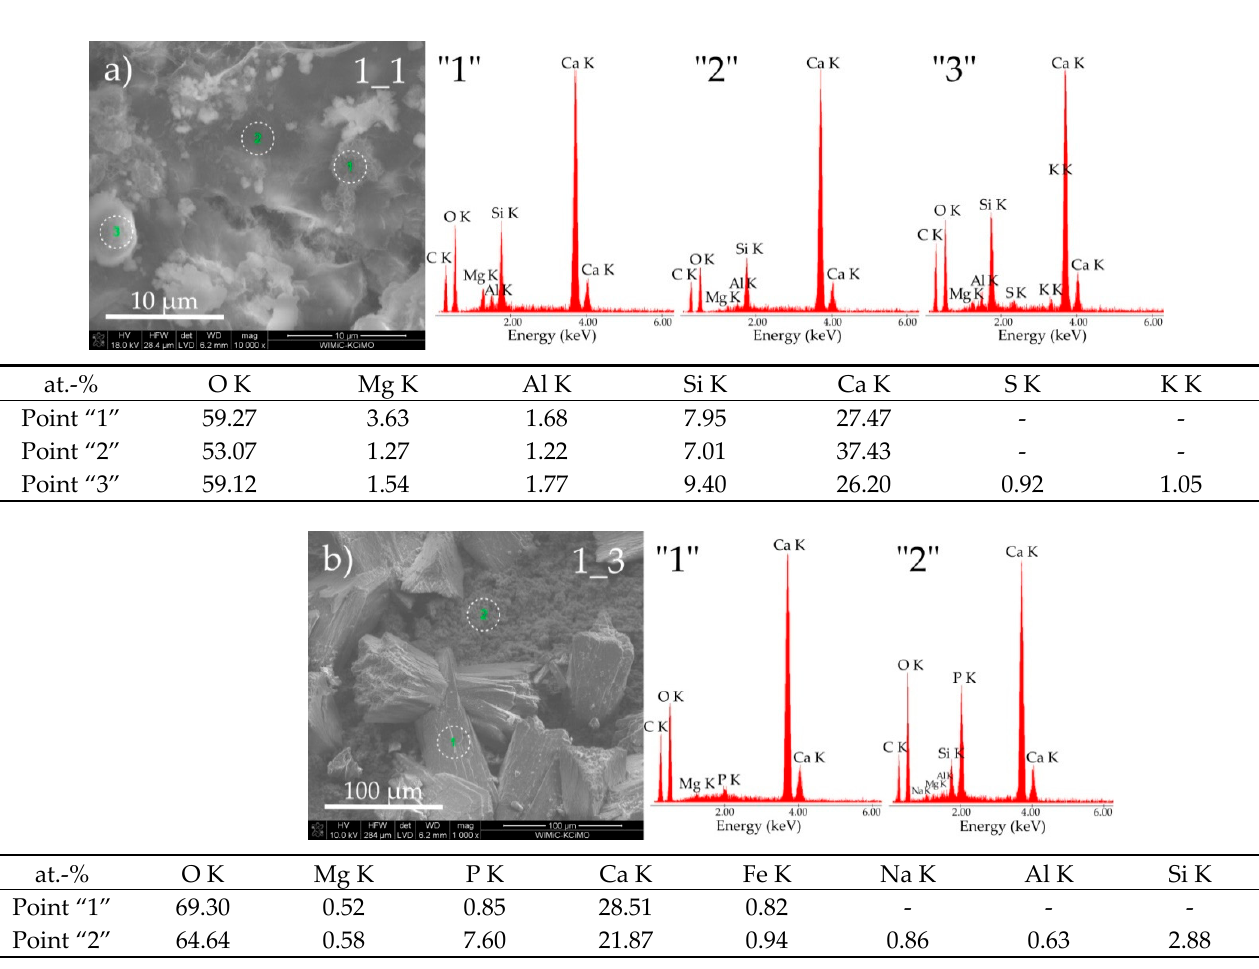
Figure 3. SEM micrographs of cement paste 1 obtained after exposure under the conditions of ( a ) water (sample 1_1) and ( b ) pig slurry (sample 1_3) with EDS quantitative point analyses from areas 1, 2, and 3.